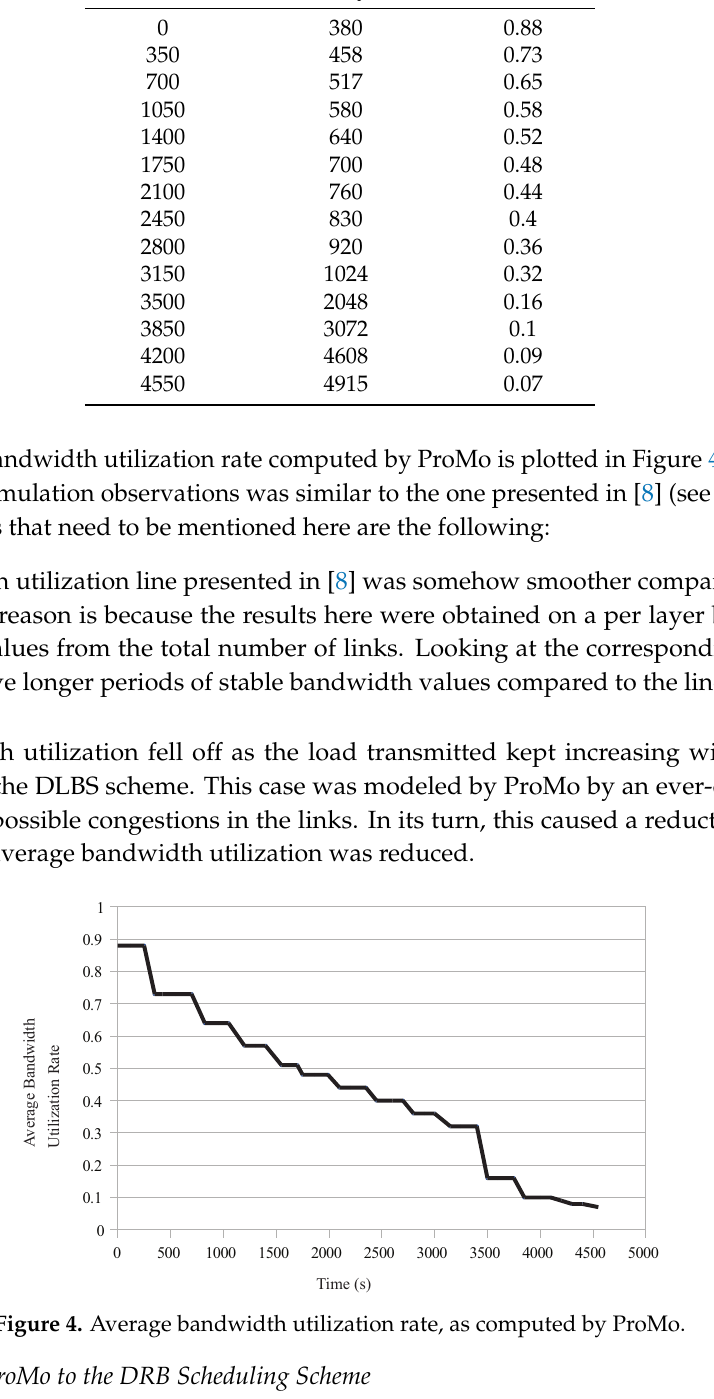
Table 3. Results recorded when executing the DLBS scheme to examine the bandwidth utilization. Time Load Transmitted